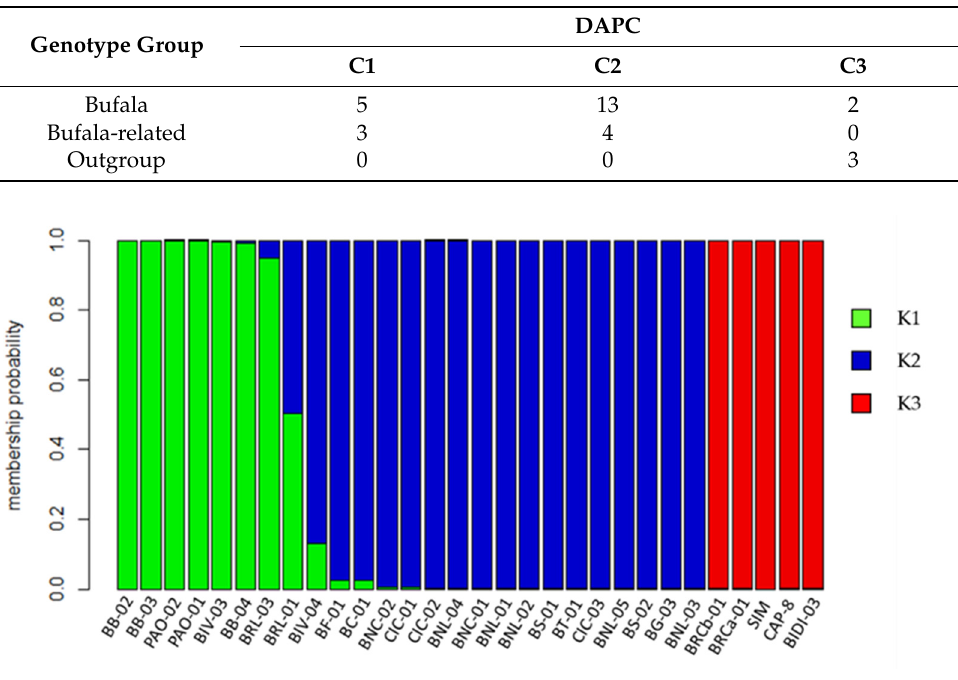
Figure 3. STRUCTURE analysis. The Y axis shows the membership probability (K-values). Each individual is represented by a vertical line, and cluster assignments is indicated by color. Individ-